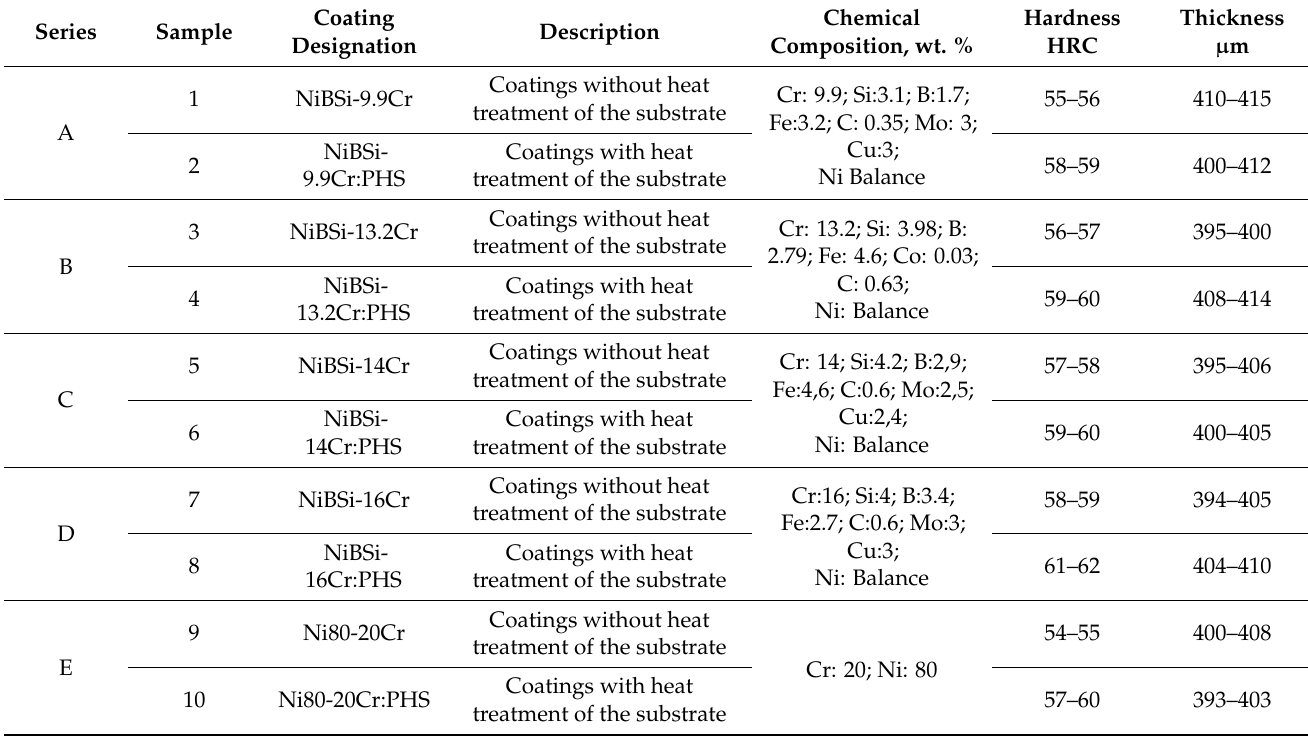
Table 1. Description, chemical composition, hardness, and thickness of the tested